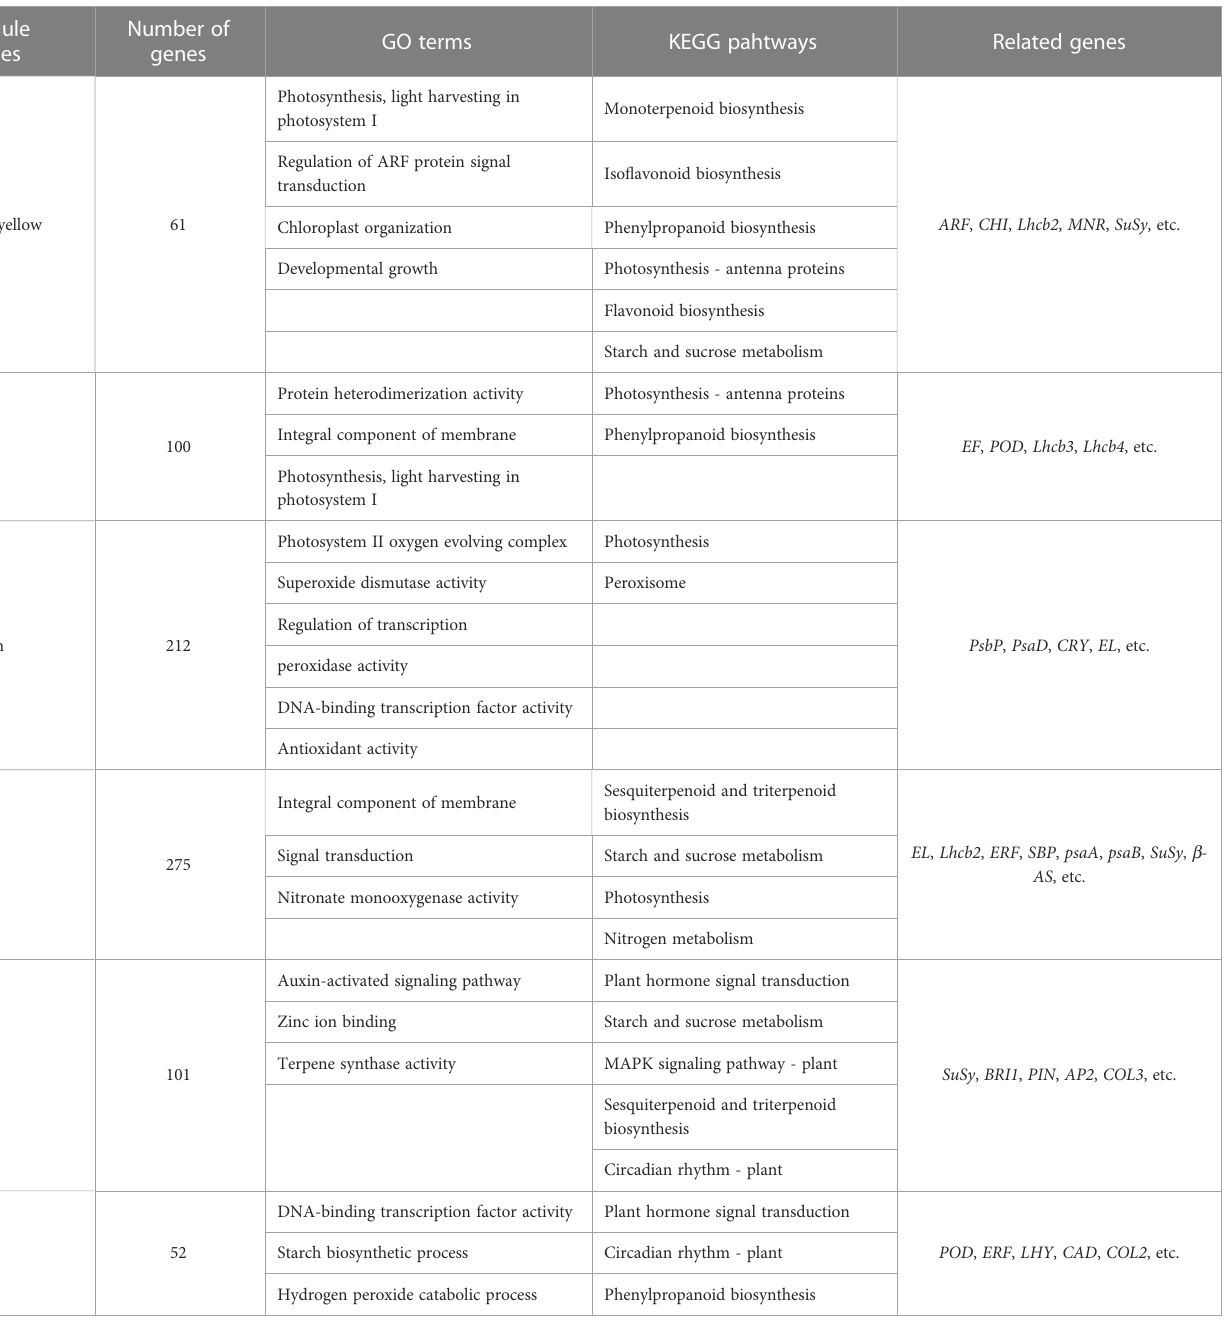
TABLE 2 Functional analysis of collected modules with network